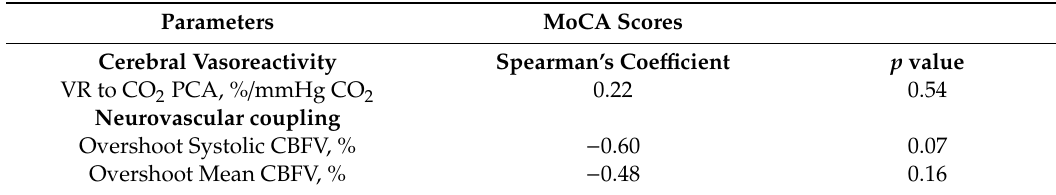
Table 3. Correlation between selected cerebrovascular regulation indexes and cognitive performance in Fabry disease